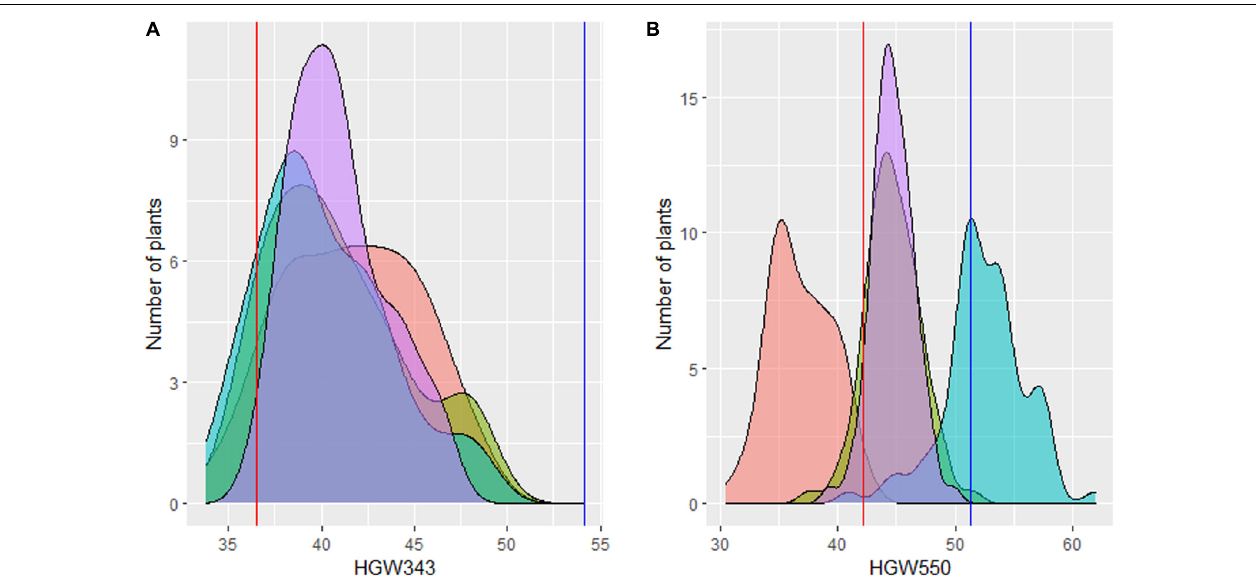
FIGURE 2 | Graphical representation of distribution of thousand grain weight of derived BC 2 F 3 - 5 . (A) HGW343 progenies and (B) HGW550 progenies with the BLUPs in each environment (purple). The BLUPs of Rye Selection111 and recurrent parents (PBW343 and PBW550) are given as vertical red lines and blue lines,